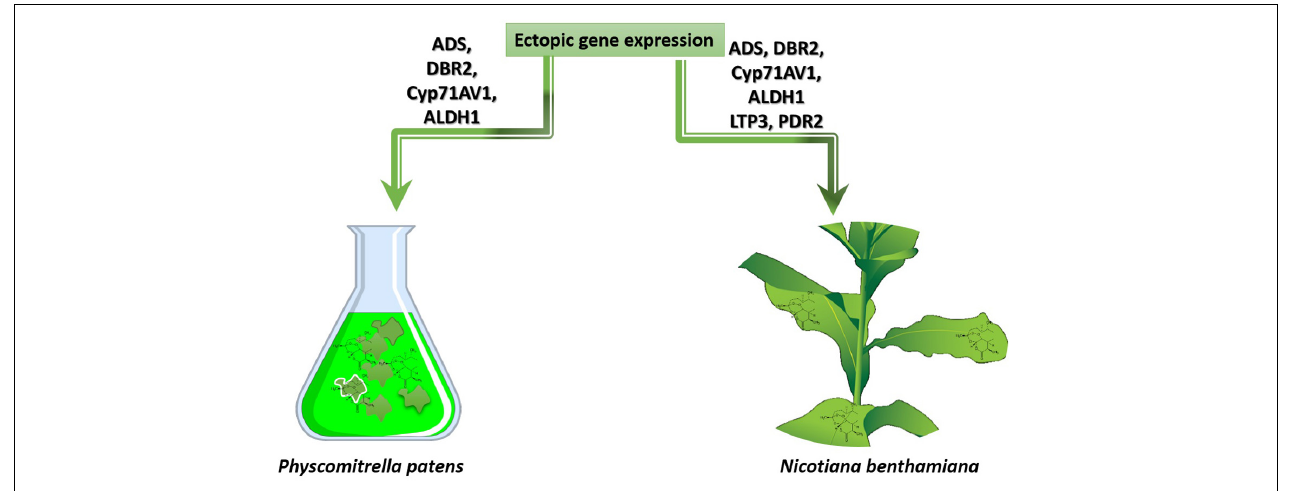
FIGURE 6 | Heterologous overexpression of genes from artemisinin biosynthetic pathway in the host plants N. benthamiana and P. patens